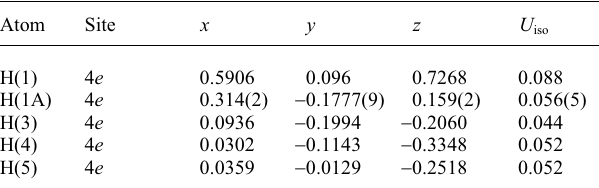
Table 2. Atomic coordinates and displacement parameters (in Å 2 ) .